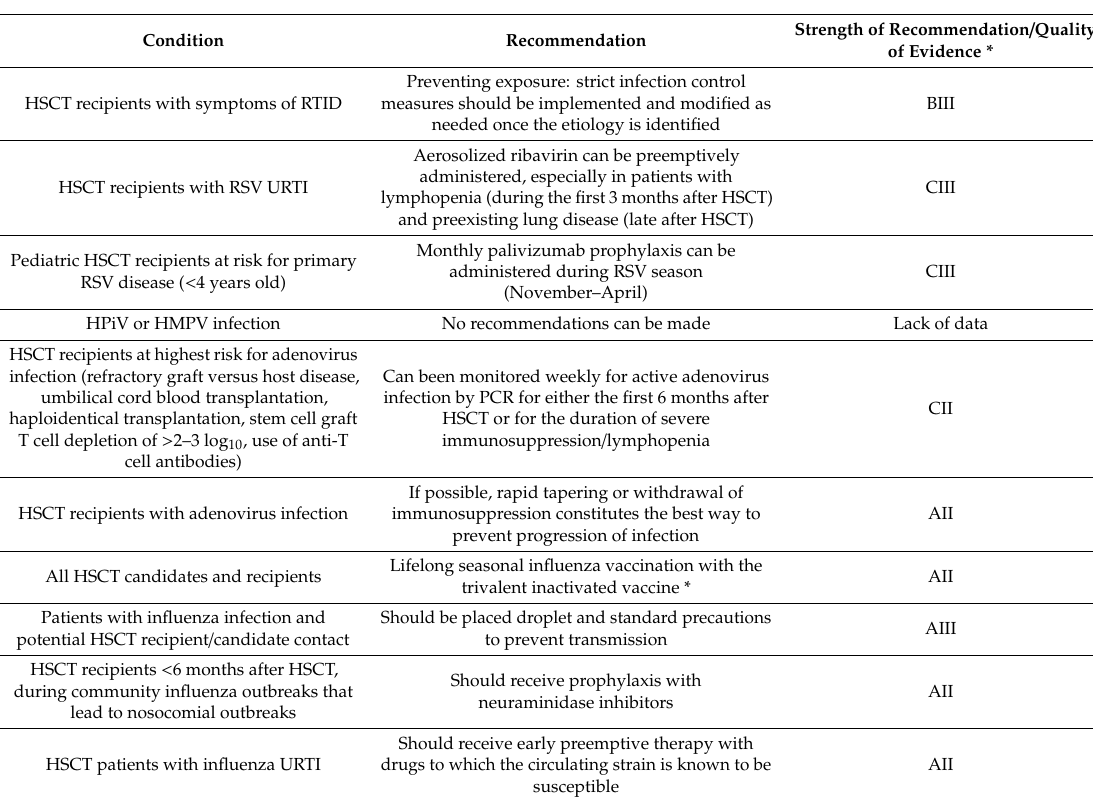
Table 6. Guidelines for Preventing Infectious Complications among Hematopoietic Cell Transplant Recipients recommendations